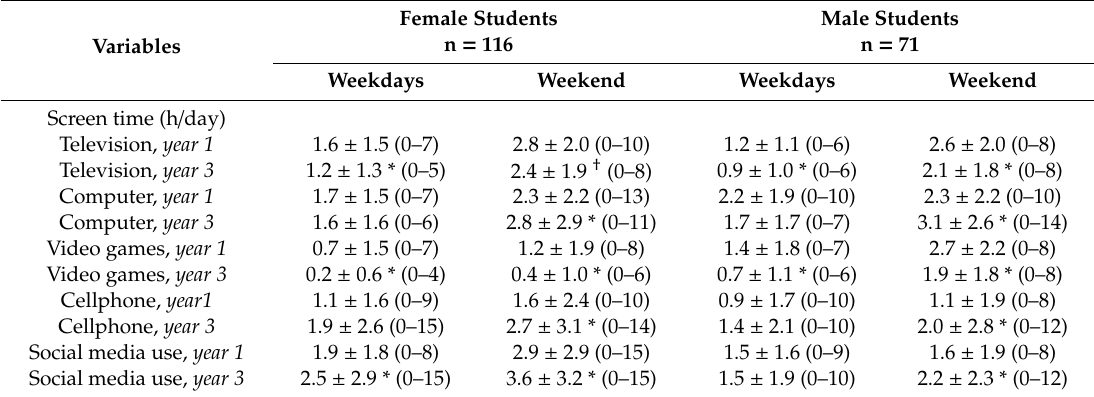
Table 2. Screen time habits on weekdays and weekends of high school female and male students.